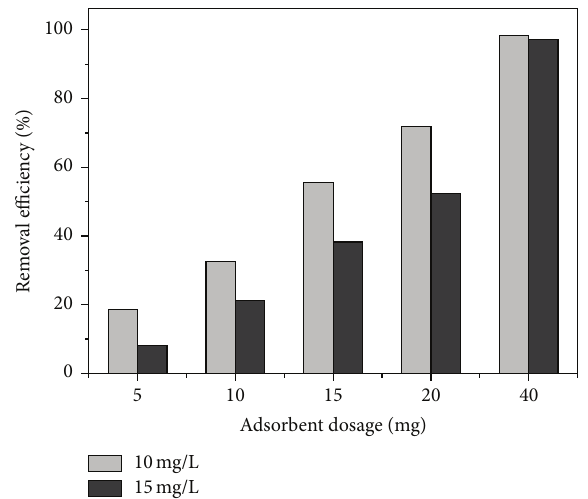
Figure 4: Effect of dosage of the CTAB-modified cornstalk biochar on ORII adsorption. The concentrations for ORII were 10 and 15 mg/L, respectively.